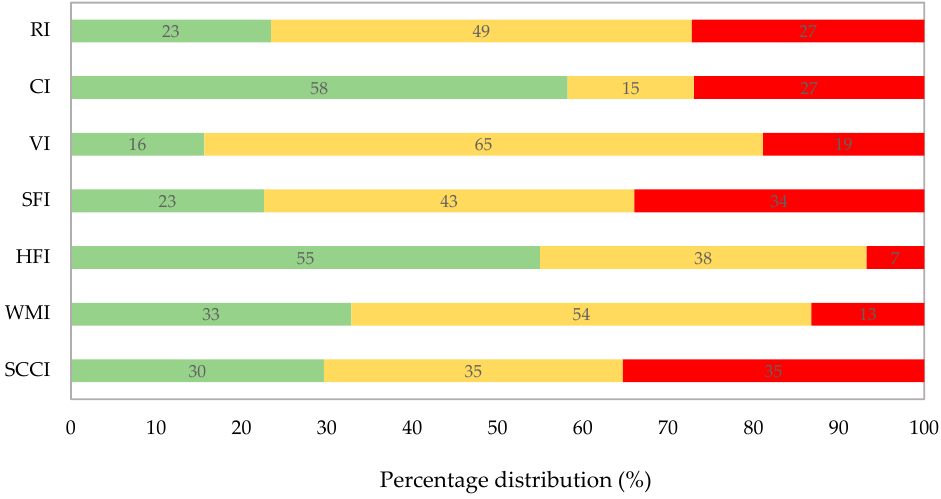
Figure 8. Summary of calculated indices. Risk index (RI), consequence index (CI), vulnerability index (VI), structural failure index (SFI), hydraulic failure index (HFI), water main condition index (WMI), and service connection condition index (SCCI).